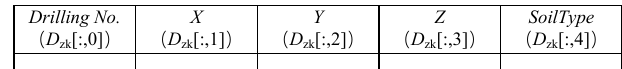
2.2 Creating geologic borehole DataFrame Generally, geological drilling information is logged in geological investigation reports (see Table 1), where D zk [:,0] represents all of the row data of the 1 st column in D zk ; D zk [:,1] represents all of the row data of the 2 nd column in D zk ; and